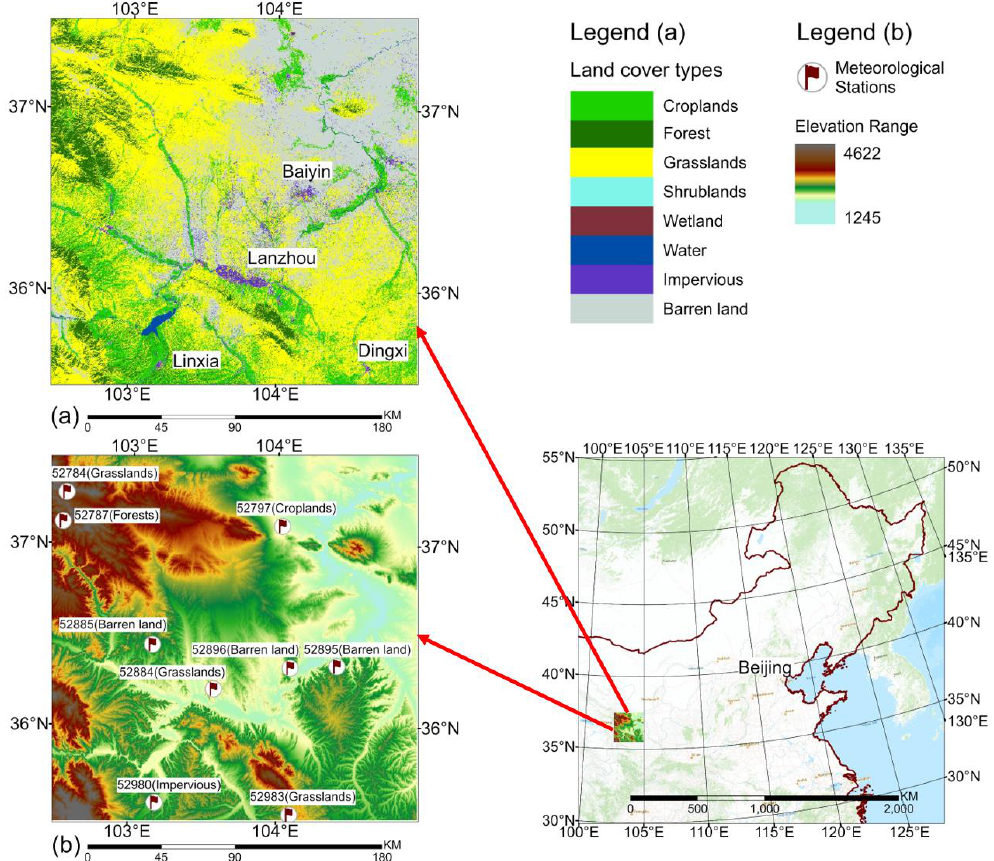
Figure 1. Land cover types and elevation of the study region. ( a ) Several land cover types are distributed in this arid and semi-arid region. The land cover data were obtained from the Finer Resolution Observation and Monitoring—Global Land Cover (FROM-GLC10) dataset, which provides land cover types of the whole globe at 10 m resolution. ( b ) The elevation of the study area ranges from 1245 to 4622 m. Nine meteorological stations are distributed at various elevations and land cover types in this region, two of which are located at elevations of more than 3300 m above mean sea level.